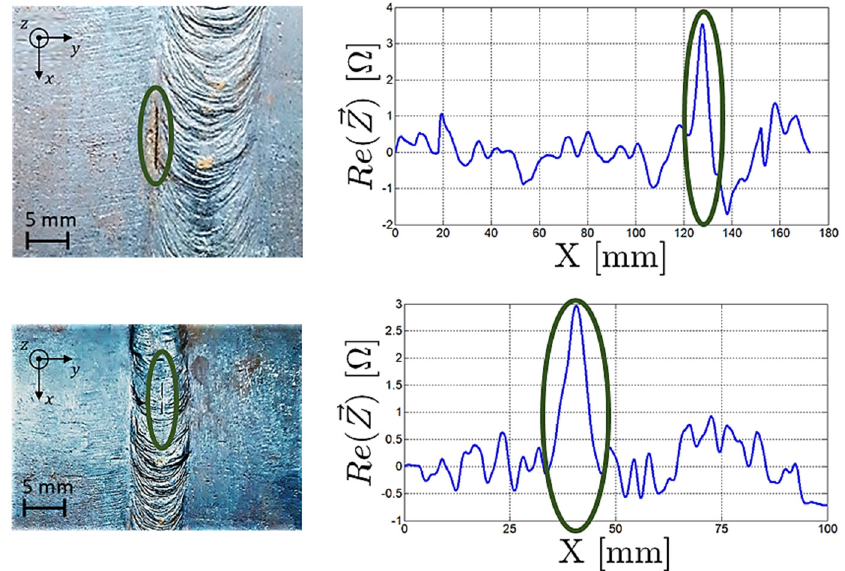
Figure 17. Output signal of the weld bead probe when scanning along the weld bead interface and centre.